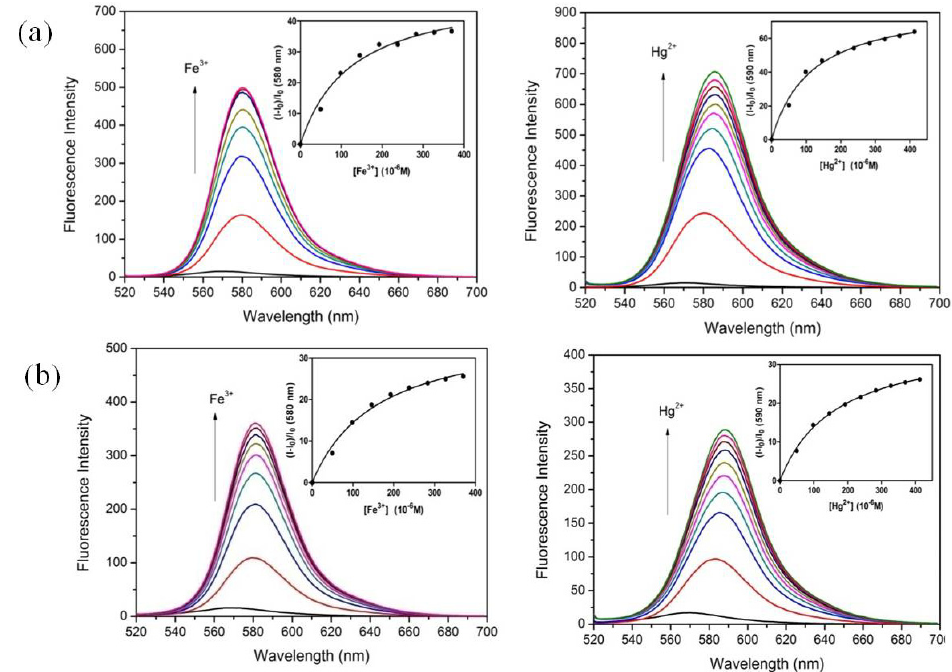
Figure 3. Changes of the fluorescence spectra of ( a ) chemosensor 1 and ( b ) chemosensor 2 = 510 nm) in CH CN/H O (3/1, v / v ) upon addition of increasing amounts of (5 μ M, λ ex 3 2 Fe 3+ (0–370 μ M, left) and Hg 2+ (0–400 μ M, right), respectively. Inset: Spectrofluorimetric =580 nm and ( b ) λ = 590 nm) for a 1:1 complex according to titration curves (( a ) λ em em Equation 1. The data are fitted to a curve with a correlation coefficient of ( a ) R 2 = 0.9952, R 2 = 0.9972 and ( b ) R 2 = 0.9945, R 2 = 0.9983.